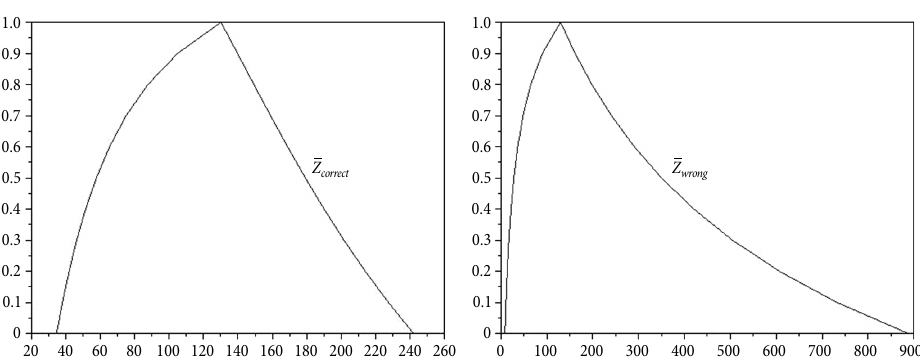
Fig. 2. Correct and wrong results in applying fuzzy arithmetic to compute the ratio Z